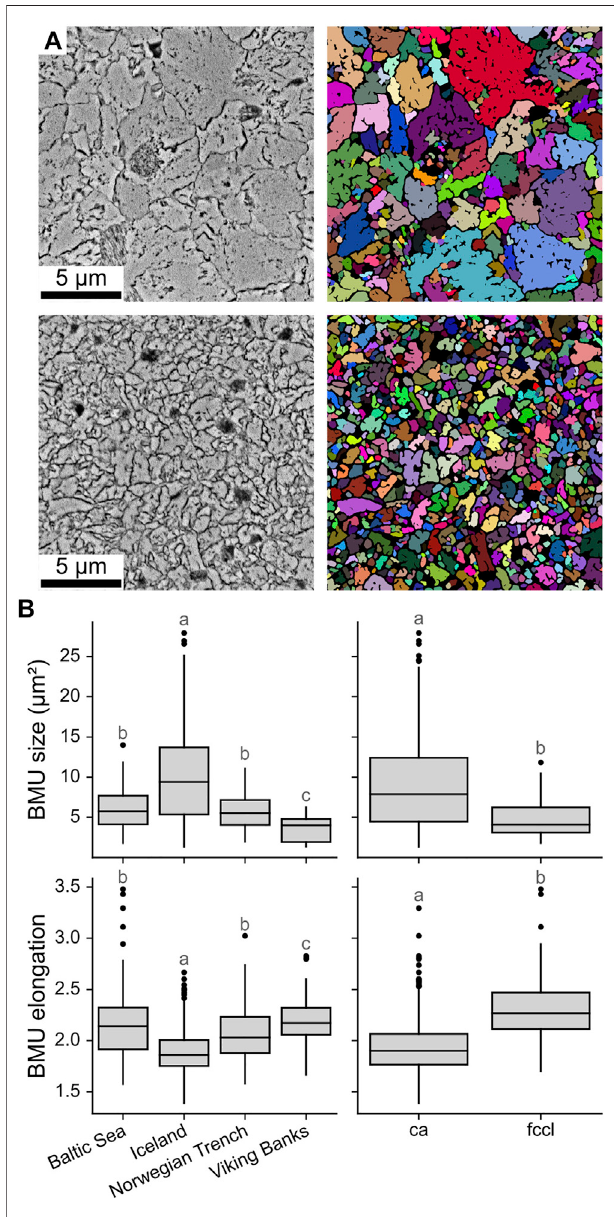
FIGURE 4 | SEM image segmentation and BMU morphology data of Arctica islandica . (A) Two shell regions (left) with large and small BMUs, respectively, and their corresponding segmentations (right). For visualization purpose, individual BMUs are displayed in individual colors, whereas the intra- and intercrystalline space is represented in black. (B) Average size and elongation of the 15 largest BMUs of each image of the hinge plates as boxplots for each locality (left) and microstructure type (right). Statistically signi fi cantly different groups ( p < 0.05) are marked with different